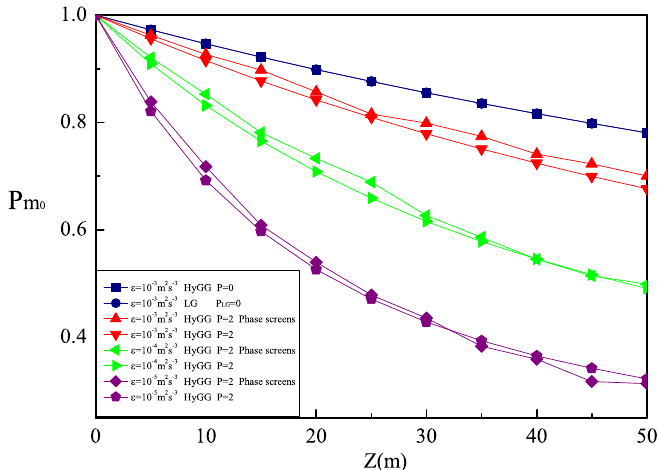
Figure 1. Detection probability P m of LG beam against z and that of the HyGG vortex beam against 0 z versus the dissipation rate of kinetic energy per unit mass of fluid ε